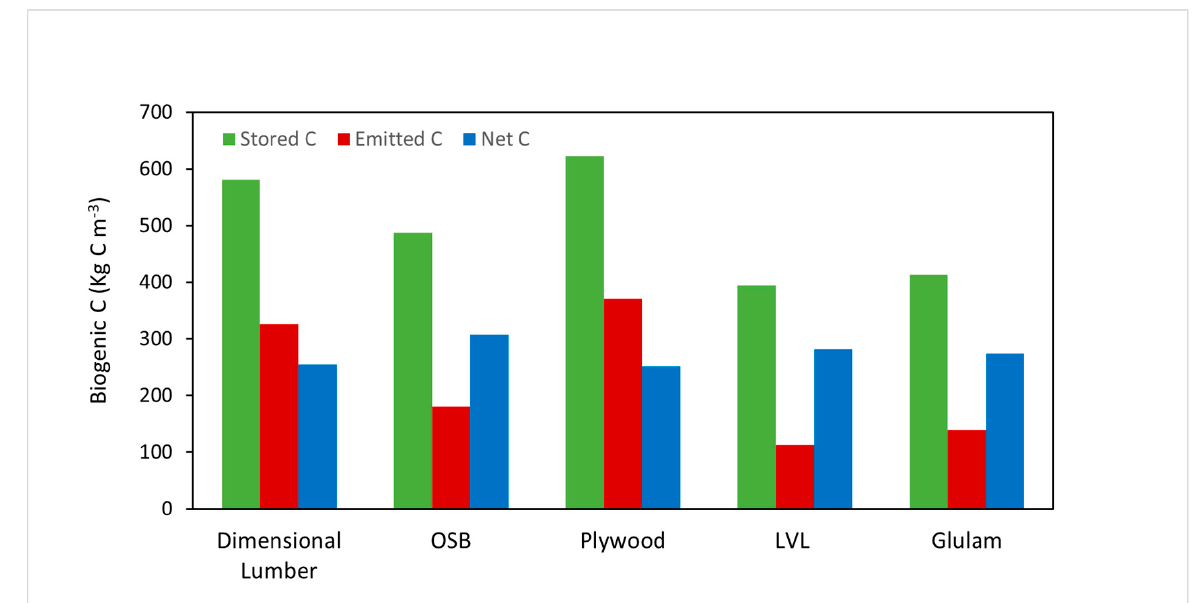
Figure 3. Biogenic carbon (temporary storage) for Southern-sourced wood products from raw material extraction through product installation. OSB = oriented strand board; LVL = laminated veneer lumber; Glulam = glue laminated lumber. Data from CORRIM Library of LCAs on Wood Products (https://corrim.org/lcas-on-wood-products-library (accessed on 19 July 2022) [100]). Second, greater global wood production will lead to global change in supply and de- mand, complemented by managed forest expansion, and greater net carbon storage